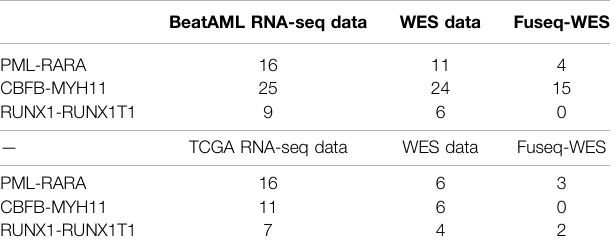
TABLE 1 | Number of supporting reads for PML-RARA in BeatAML samples. Sample ID